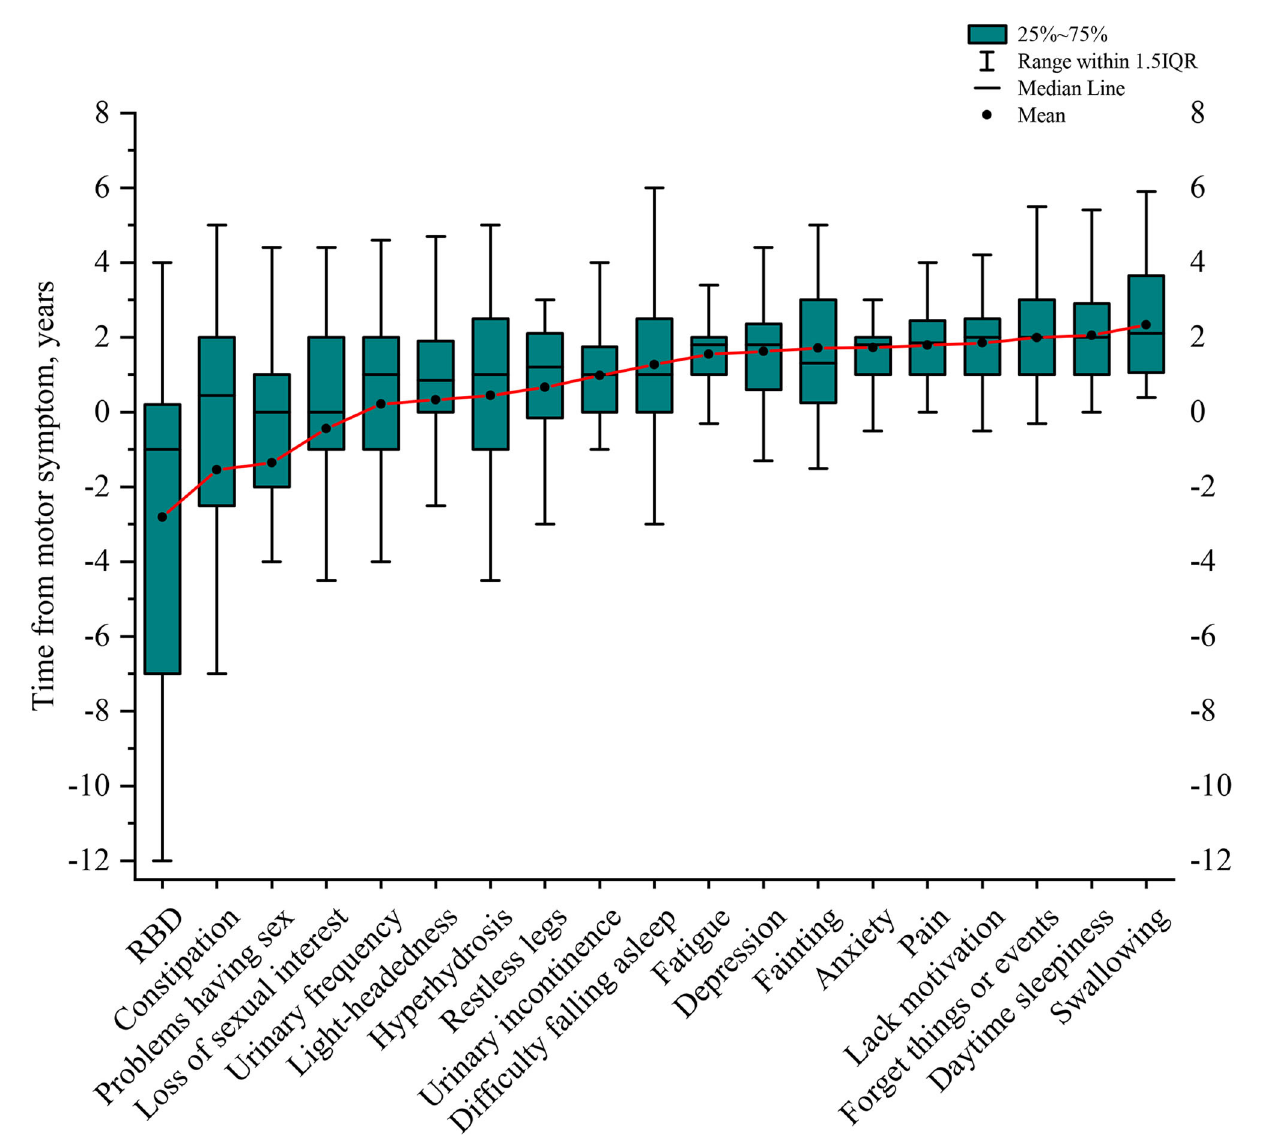
FIGURE4 Timeline of NMS presence in relation to the onset of motor symptoms in MSA. RBD was the earliest sign, followed by constipation, sexual problems, and a loss of sexual interest before motor symptoms started. The following NMS started nearly at the same time as motor symptoms, including urinary frequency, light-headedness, hyperhidrosis, restless legs, and urinary incontinence. As the disease progresses, patients with MSA might have difficulty falling asleep, fatigue, depression, fainting, anxiety, pain, lack of motivation, forgetting things or events, daytime sleeping, and develop swallowing difficulties at the late stage of the disease. NMS, non-motor symptoms; MSA, multiple system atrophy; RBD, REM sleep behavior